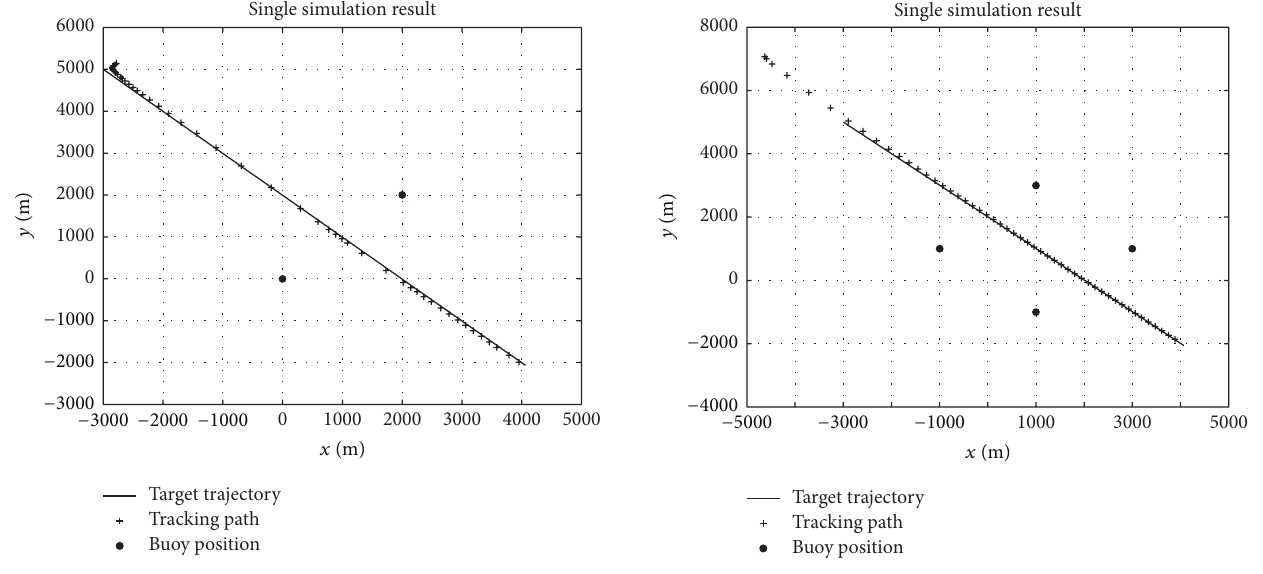
Figure 6: Schematic diagram of a single simulation tracking.